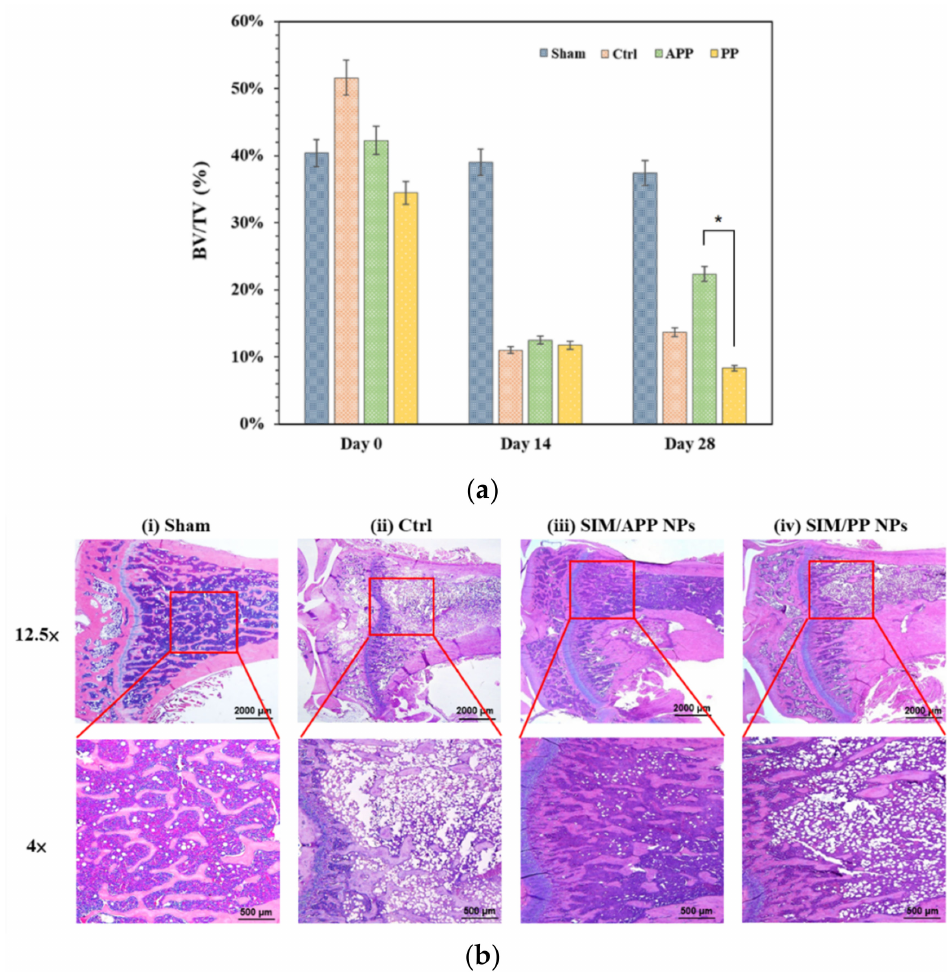
Figure 8. The effective bone formation ability of SIM nanocarriers in the disuse osteoporosis SD rat model after hindlimb suspension for 1 month. There were the following four groups: (i) sham group—no hindlimb suspension and no SIM drug treatment; (ii) control (Ctrl)—hindlimb suspension and no SIM treatment; (iii) SIM/APP NP group—hindlimb suspension and SIM/APP NP treatment; and (iv) SIM/PP NP group—hindlimb suspension and SIM/PP NP treatment. Micro-CT was used to analyze the distal portion of the tibia bone, and the bone volume to total volume (BV/TV) ratio results represent the means ± standard deviation ( n = 3) ( a ). (*) indicates significant differences of p < 0.05. H&E staining also revealed the distal portion of the tibia bone tissue histologic sections ( b